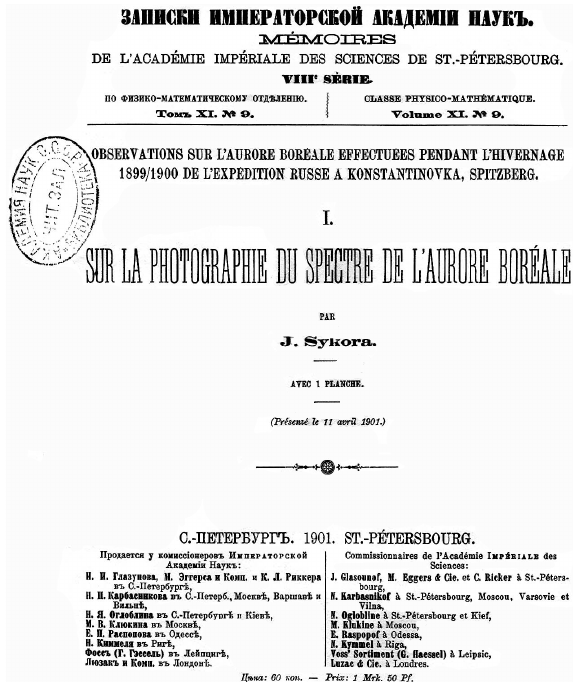
Fig. 5a. Cover page of the report by Sykora